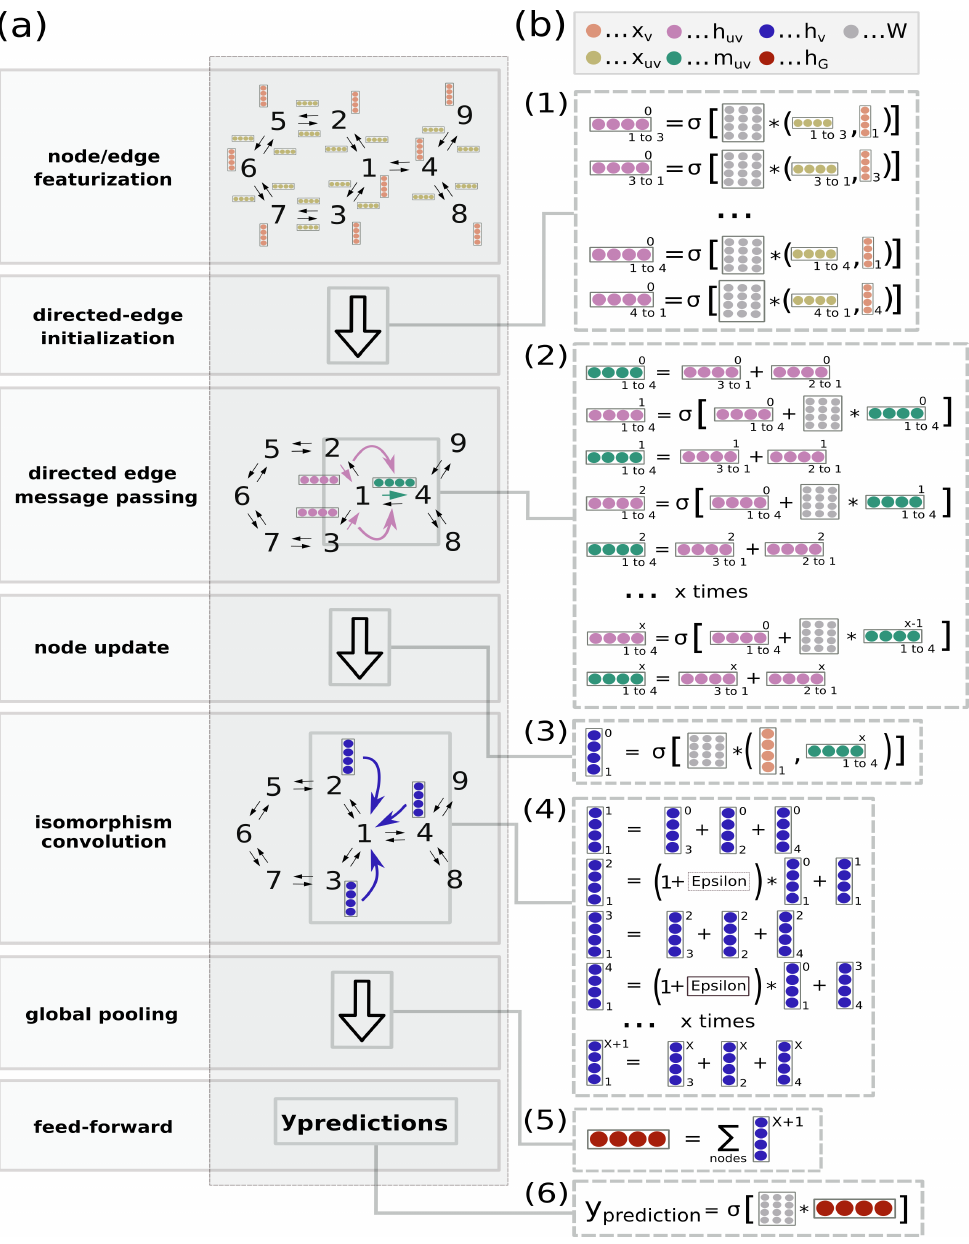
Figure 1. High level representation of the directed-edge graph isomorphism network (D-GIN) architecture for physicochemical prediction (logD, logS, or logP). ( a ) High level workflow depicting how a graph and its nodes and edges are featurized, then fed into the D-GIN to generate a molecular graph embedding. ( b ) The D-GIN architecture at a low level. Steps involved in generating input to make predictions: 1) Initial hidden directed-edge features ( h 0 uv ) are initialized by concatenating the corresponding node ( x v ) and directed edge ( x uv ) features. (2) Directed edge messages ( m uv ) are used to update the hidden directed-edge features ( h t uv ). (3) Directed messages are combined with their corresponding hidden node features ( h v ), and (4) iteratively updated by an additional trainable identifier (epsilon). (5) Hidden node features are aggregated to generate the molecular embedding ( h G ) which is used as input for (6), the feed-forward neural